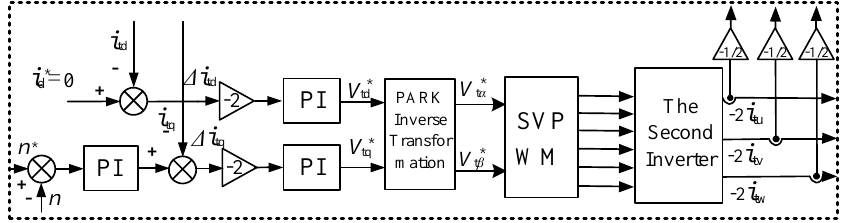
Figure 10. Block diagram adopting the torque control strategy.